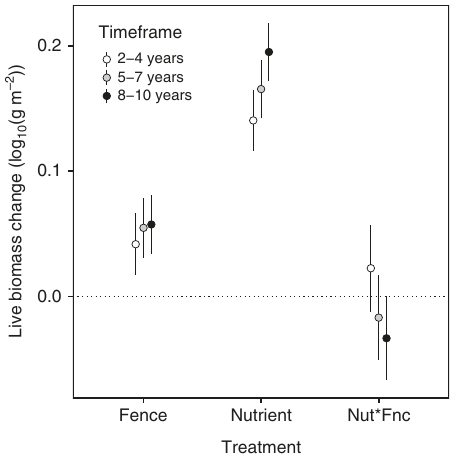
Fig. 2 Treatment effects on aboveground grassland biomass were similar for sites with 2 – 4 years of response data ( n = 58, open circles), at least 5 years ( n = 42, gray), and at least 8 years ( n = 24, black). Error bars represent 95% con fi dence intervals. Main effect values represent model mean differences of the experimental treatment from the control after controlling for site and year as random effects. The nutrient by fence interaction ( “ Nut*Fnc ” ) is compared to the sum of the effect of nutrients alone and fencing alone, such that zero indicates